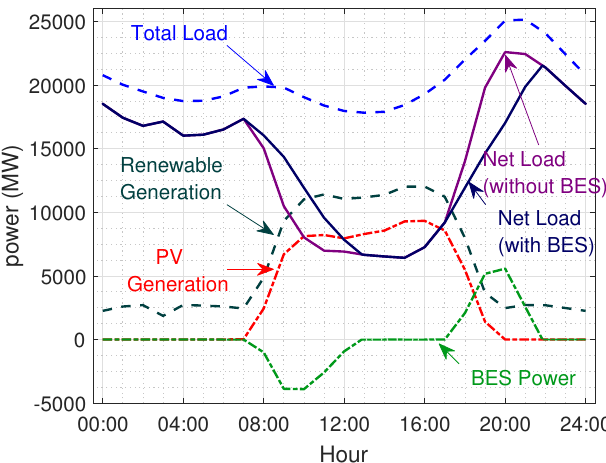
Figure 19. Shaping of Daily Load Profile: Scenario I.